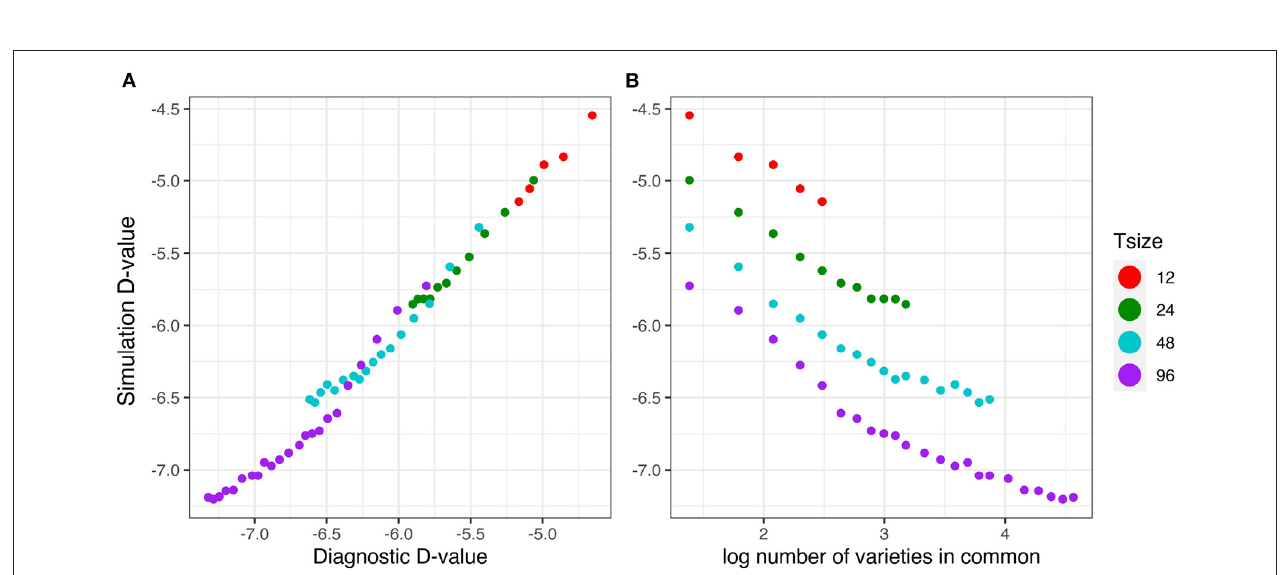
FIGURE 5 | Independent VE effects simulation study: Simulation based D S 1 c (I)-values plotted against (A) diagnostic D 1 c (I)-values and (B) log number of varieties in common for four trial sizes (trials with 12, 24, 48, and 96 varieties) and a sequence of connectivity levels. Trial sizes (Tsize) are represented using different colours. Each point within Tsize corresponds to a different level of variety connectivity which ranges from c = 4 up to the number of varieties in a trial (representing 100% connectivity between the two trials).